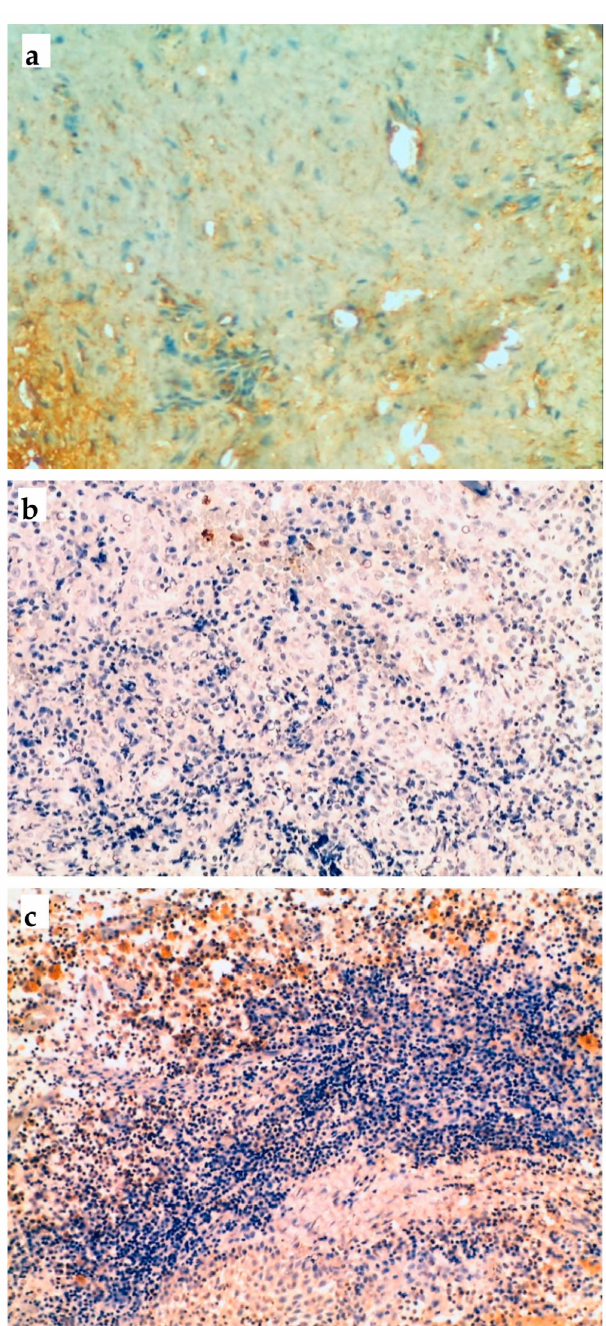
Figure1. Immunohistochemicalexpressionofcellmarkersevaluatedintheperiradicularlesionsstudied: ( a ) MMP-9 (100 × magnification); ( b ) PTHrP (100 × magnification); ( c ) RANK (100 ×